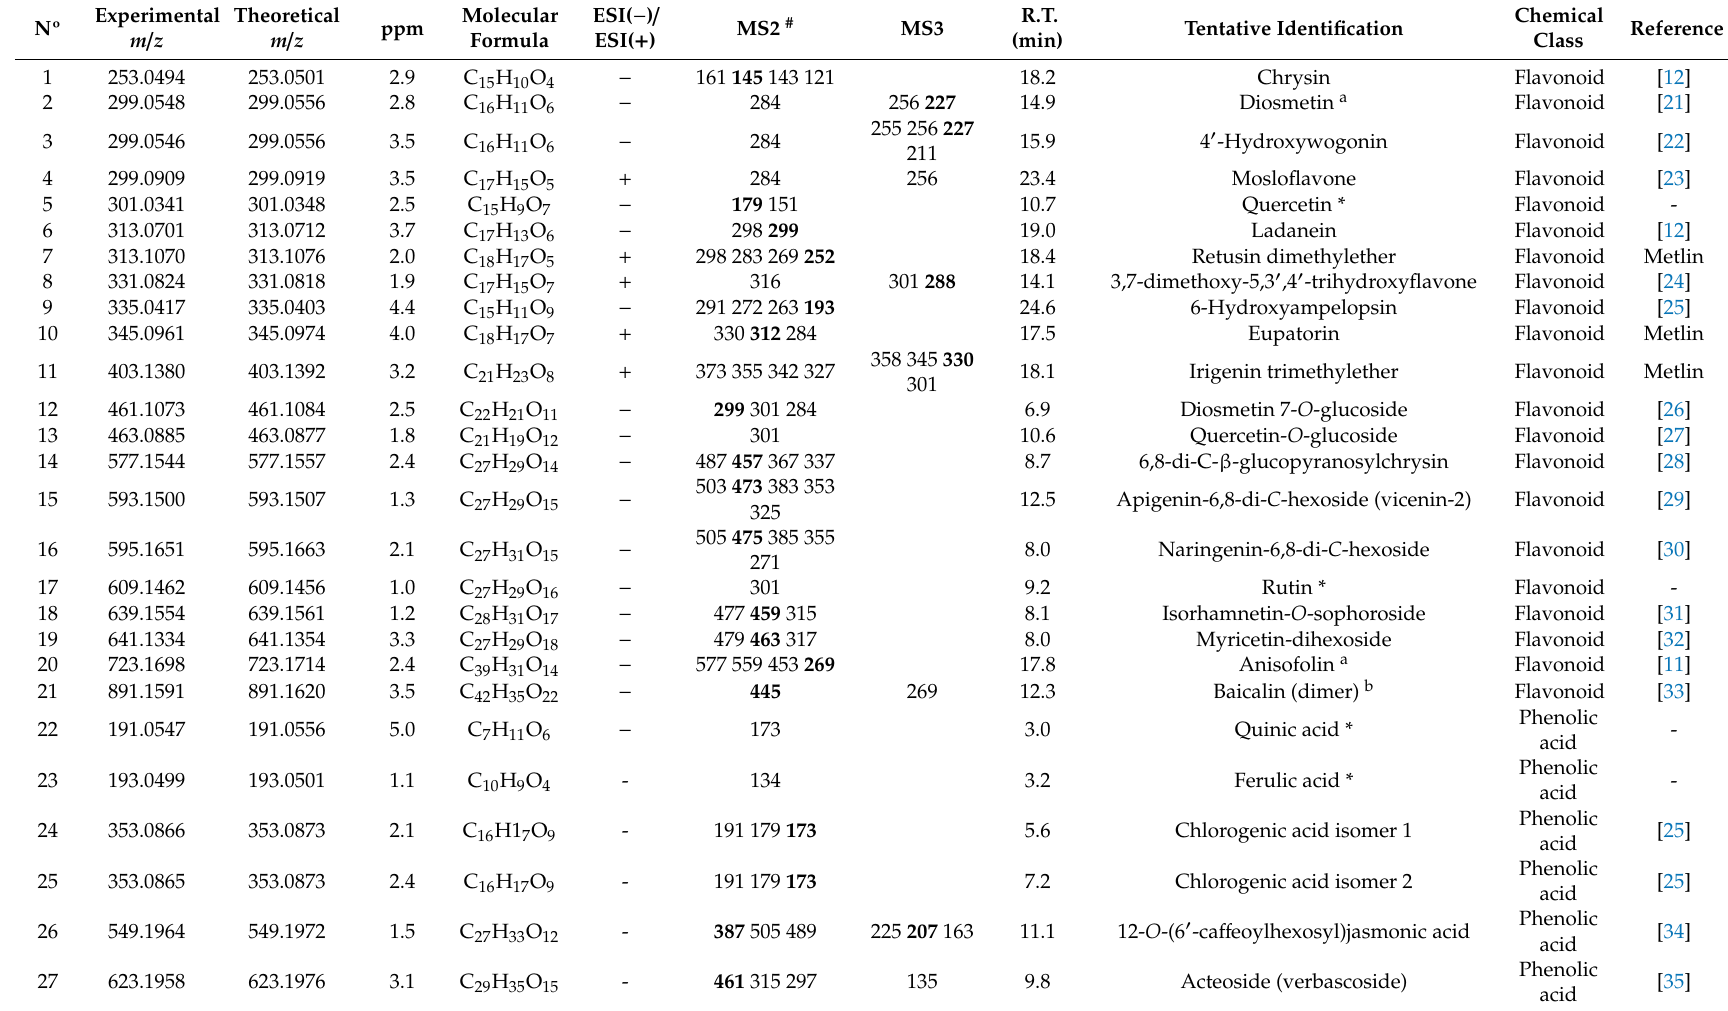
Table 1. Identification of polar constituents from the methanol extract of Colebrookea oppositifolia by HPLC-MS n